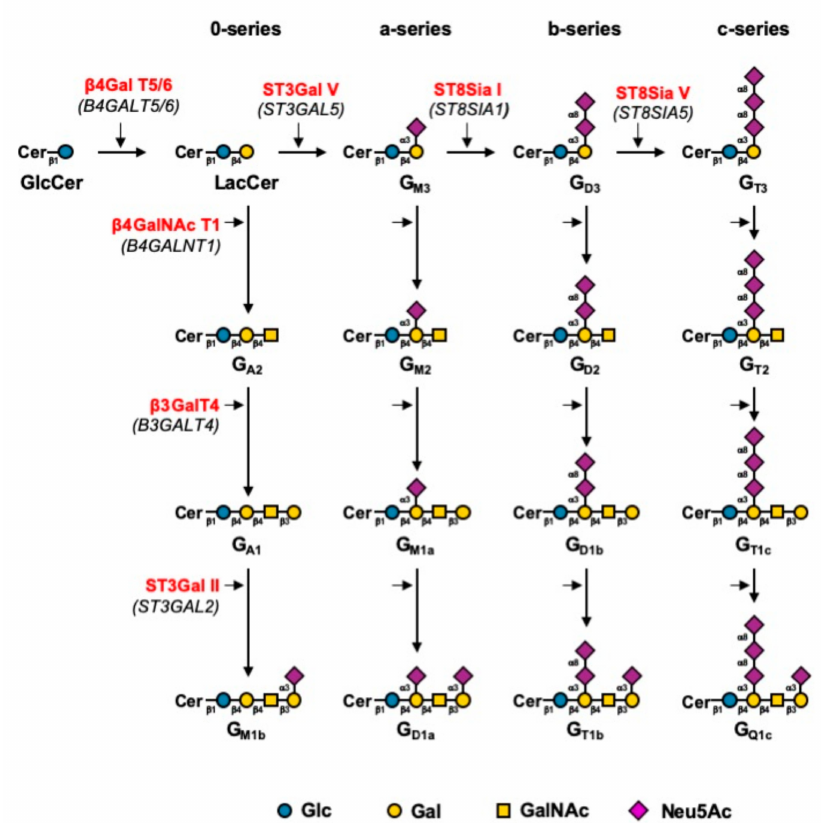
Figure 1. Biosynthesis pathway for gangliosides [2]. Gangliosides are synthesized by stepwise addition of monosaccharides to GlcCer. Extension of GlcCer occurs through the action of the UDP-Gal: GlcCer β 1,4-galactosyltransferase to make lactosylceramide (LacCer). The action of the GM3 synthase, GD3 synthase, and GT3 synthase leads to the biosynthesis of the precursors of a-, b-, and c-series gangliosides, respectively. The 0-series gangliosides are directly synthesized from LacCer. Elongation is performed by the sequential action of β 4GalNAc T1, β 3Gal T4, and the sialyltransferases ST3Gal II and ST8Sia V. Genes encoding the di ff erent glycosyltransferases involved are indicated in italics between